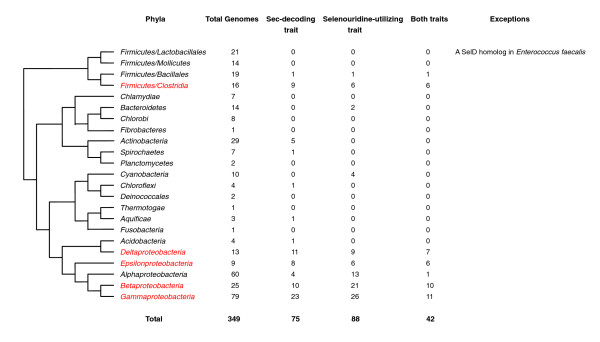
Distribution of selenium utilization traits in different bacterial taxa. The tree is based on a highly resolved phylogenetic tree of life derived from a concatenation of 31 orthologs occurring in 191 species with sequenced genomes [23]. We simplified the complete tree and only show the bacterial branches. Phyla containing the majority of Sec-decoding organisms are shown in red.